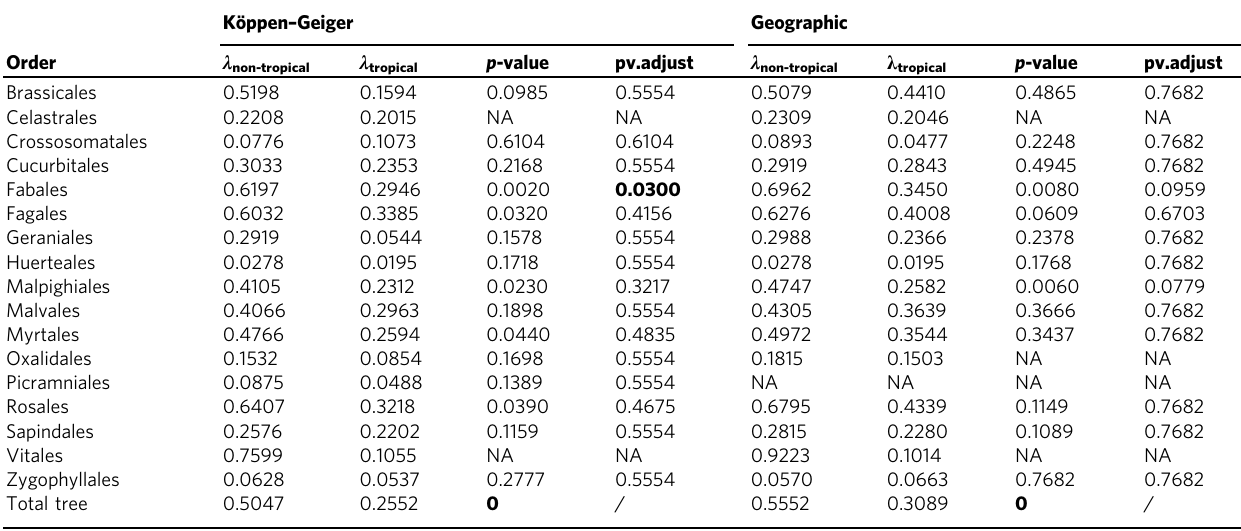
Table 2 Summary of correlation tests between tip rates and the two binary tropicality data sets in FiSSE.